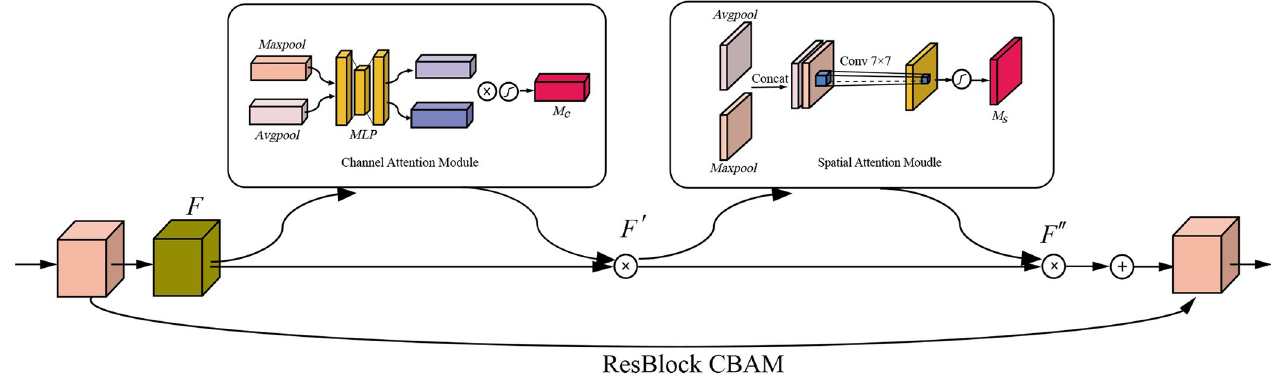
Fig 4. CBAM module.